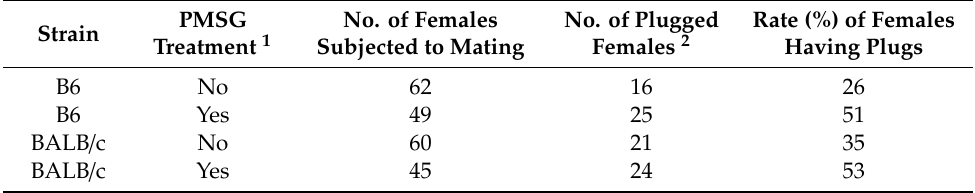
Table 3. Summary of the rates of females having plugs after low-dose PMSG